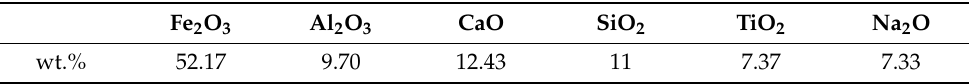
Figure 4. PXRD pattern of the solid residue after water leaching of the thermal product (roasting BR and NaOH at 600 °C, under H 2 gas). Table 3. Normalized chemical composition of the solid residue, after water leaching of the thermal product (roasting BR and NaOH at 600 °C, under H 2 gas).